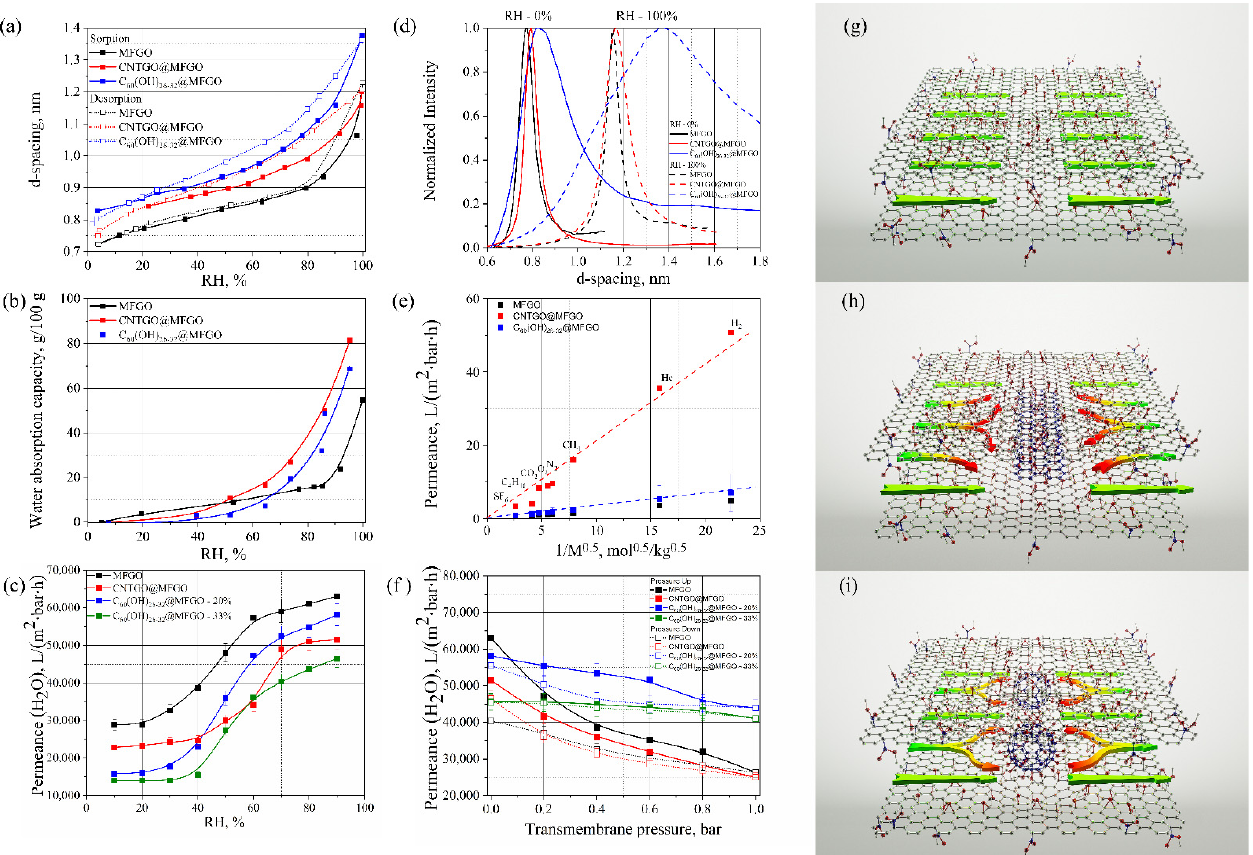
Figure 3. The relative humidity (RH)-dependencies of ( a ) d-spacing; ( b ) water adsorption capacity (at T = 23 °C); ( c ) water-vapor permeance of composite membranes; ( d ) GIWAX data at RH of ~0% and ~100% for composite membranes; ( e ) permanent gases permeance; ( f ) transmembrane pressure- dependence of water-vapor permeance (90% RH) of the composite membranes; schemes of the changes in the diffusion pathways in pure GO ( g ) and GO-intercalated with nanoribbons ( h ) and fullerenols ( i ) .